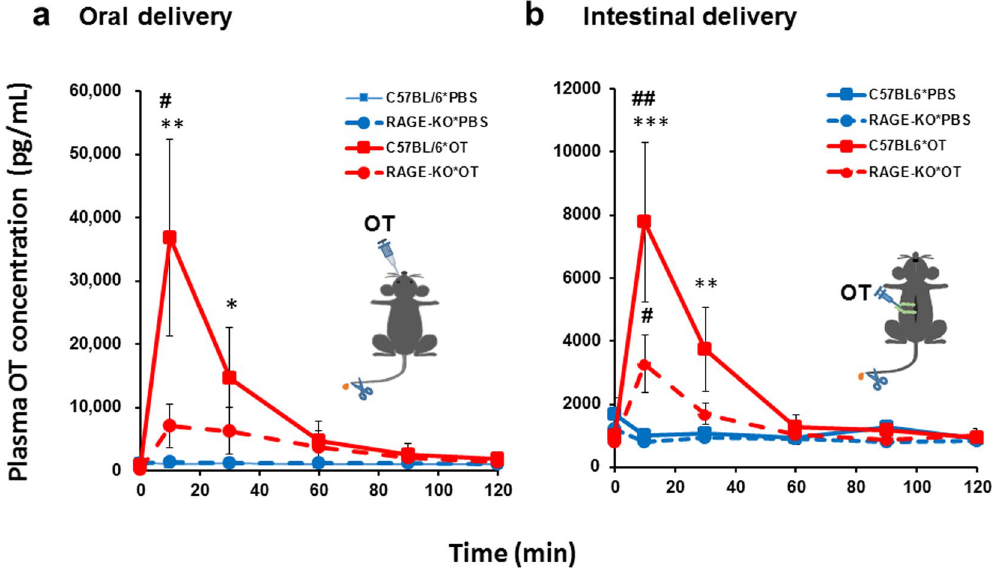
Figure 5. Plasma OT levels in adult male mice after oral or intestinal delivery of OT and PBS. Blood samples were collected at the indicated time from the tail after administration of OT (10 μ g/mouse) into the mouth (100 μ M × 100 μ L, ( a ) or the upper intestinal tract (100 μ M × 100 μ L, ( b ). Wild-type (WT; N = 3 for ( a) and ( b ) or Ager − / − (RAGE KO; N = 4 for ( a) and b ) mice of PND56-65 were anesthetized, and the tails were cut repeatedly for the collection of 30 μ L of blood (Insets). ( a ) Two-way ANOVA, F 1,48 = 4.66, P < 0.05. Bonferroni’s post hoc tests showed significant differences between the two genotypes ( # P < 0.01). Significantly different from the control value at * P < 0.05 and ** P < 0.01, respectively. ( b ) A two-way ANOVA for interaction